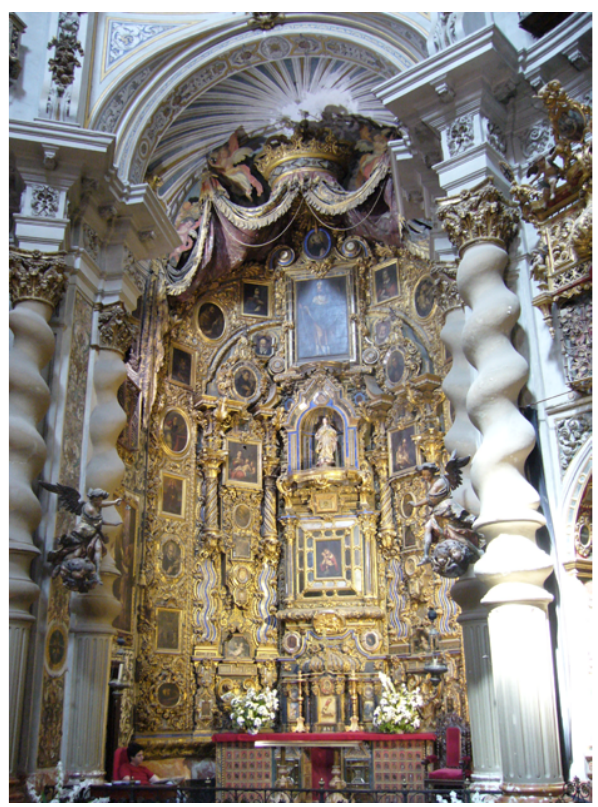
Figure 19: Interior of the former Jesuit novitiate church of San Luis de los Franceses, Seville. View of the High Altar. Photo by